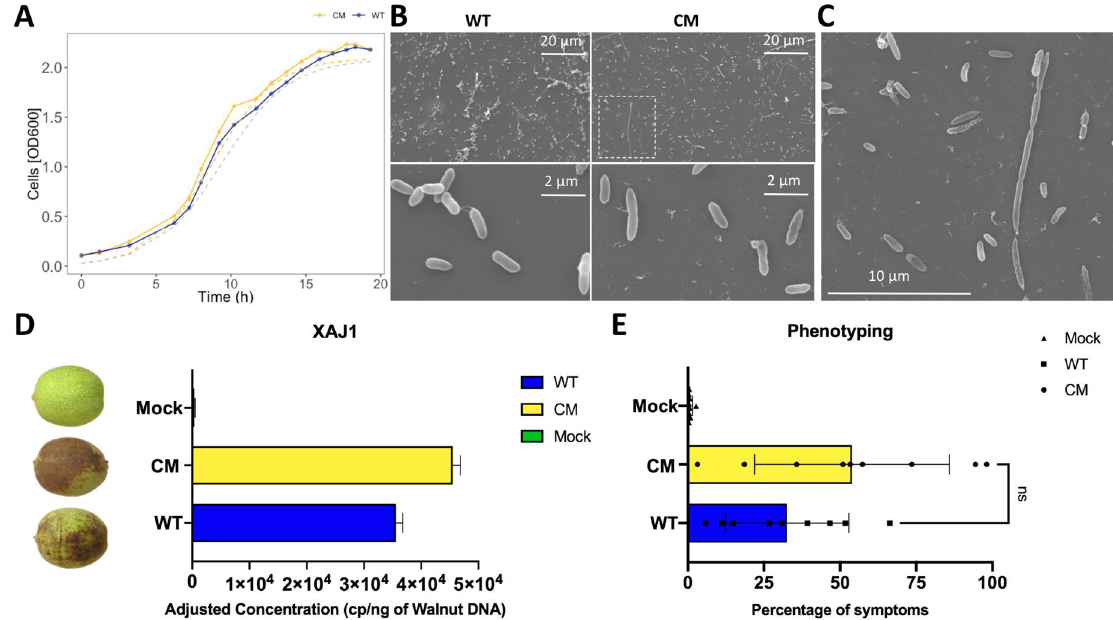
Figure 2. ( A ) Xaj WT and XajCM mutant growth curves. Dotted lines represent predicted OD values according to the model of growth for the samples analyzed. ( B ) In vitro microscopy of Xaj WT (left) and XajCM (right) cultures, magnification of 1200 × (top) and 12,000 × (bottom). ( C ) XajCM linear shape forming a chain of individual cells similar to a streptobacilli form (magnification of 3500 × ). ( D ) Quantification of Xaj in plant tissue by dPCR and ( E ) Walnut blight phenotyping in walnut fruits using ImageJ.